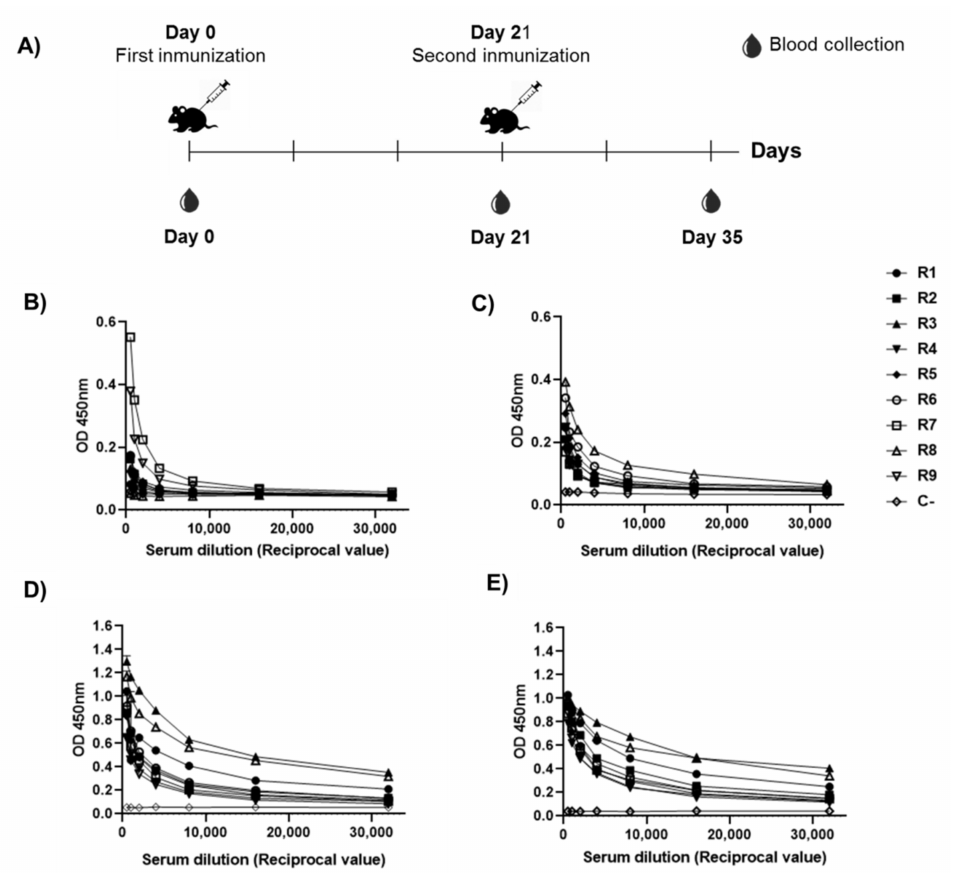
Figure 8. Immunogenicity studies in mice. ( A ) Schematic representation of immunization protocol and sample collection. The mice were divided into two experimental groups of nine mice each, one group immunized with 10 µ g of RBD-CD and negative control that was immunized with PBS followed by a booster dose at 21 days after the first immunization. Mice sera were collected on day 0 (pre-immune serum) and at 21 and 35 days after starting the experiment to evaluate specific IgG titers by ELISA. Serum was diluted from 1:500 to 1:32,000. ( B , D ) ELISA using RBD-H6-HEK as coating antigen. ( C , E ) ELISA using RBD-CD as coating antigen. ( B , C ) 21 days after primary immunization. ( D , E ) 35 days after primary immunization (14 days post-booster). C-: Serum from the placebo